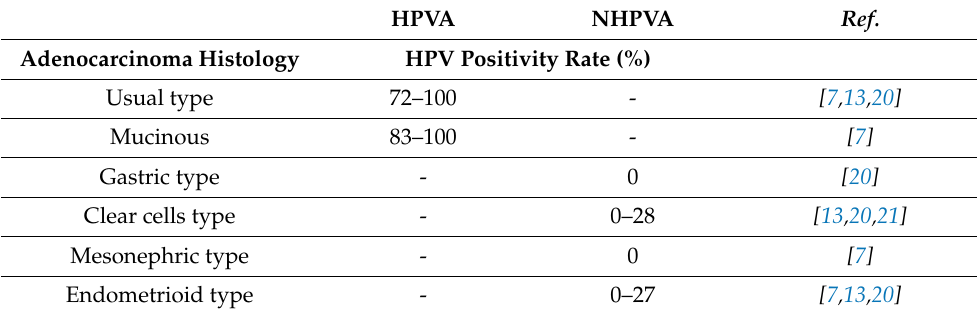
Table 1. HPV-positivity rate according to histologic